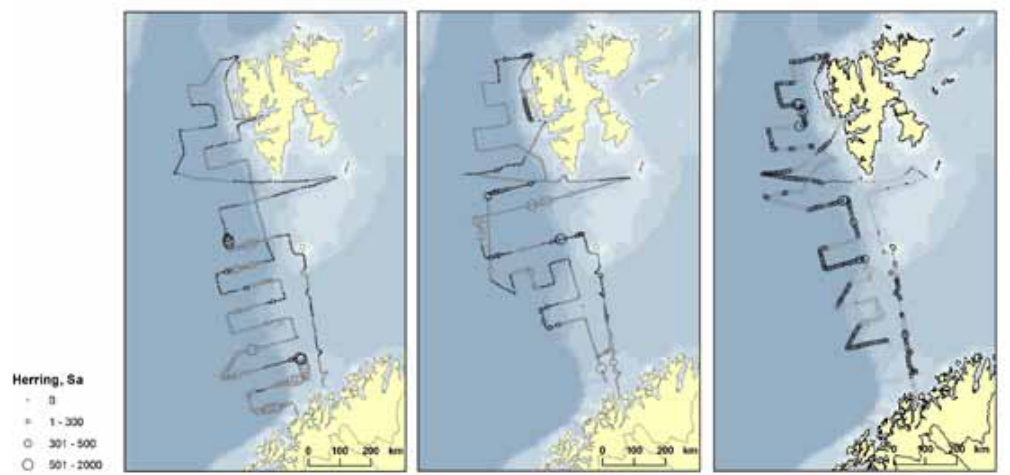
Fig. 5. Distribution of herring along the cruise lines in 2000, 2001 and 2002. Black cruise line segments indicate segments with observer effort >0 which are included in the statistical analyses of cetacean habitat and prey selection, grey cruise line segments indicate segments with observer effort=0 which are not included in the statistical analyses.